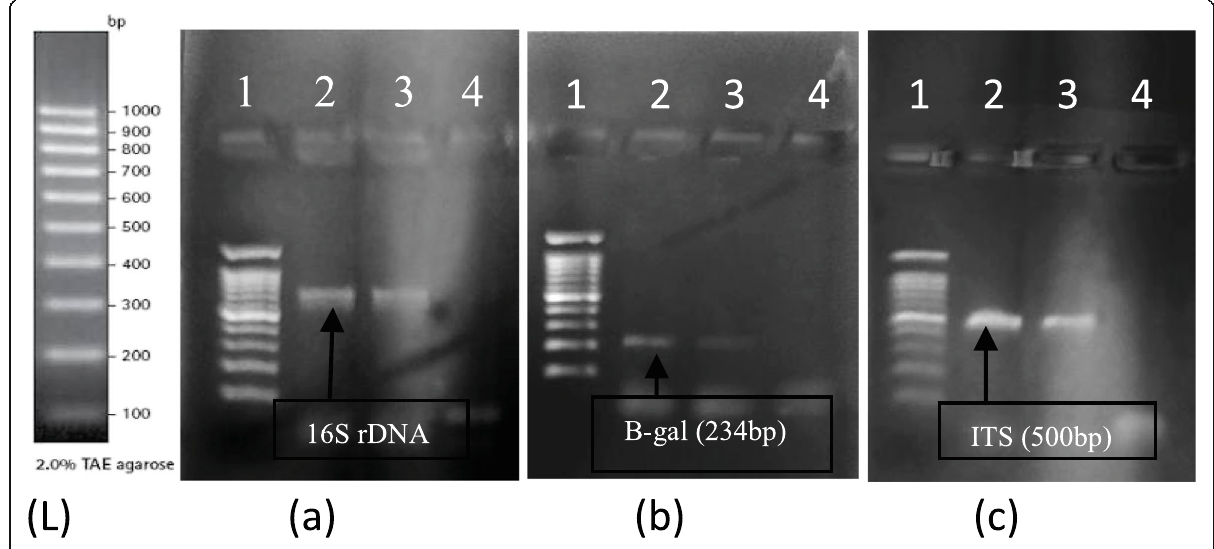
Fig. 2 16s rDNA, LacZ3, and ITS region amplification using genomic DNA and colony as a template. (L)-100 bp Ladder. a 16s r-DNA: lane 1 — 100